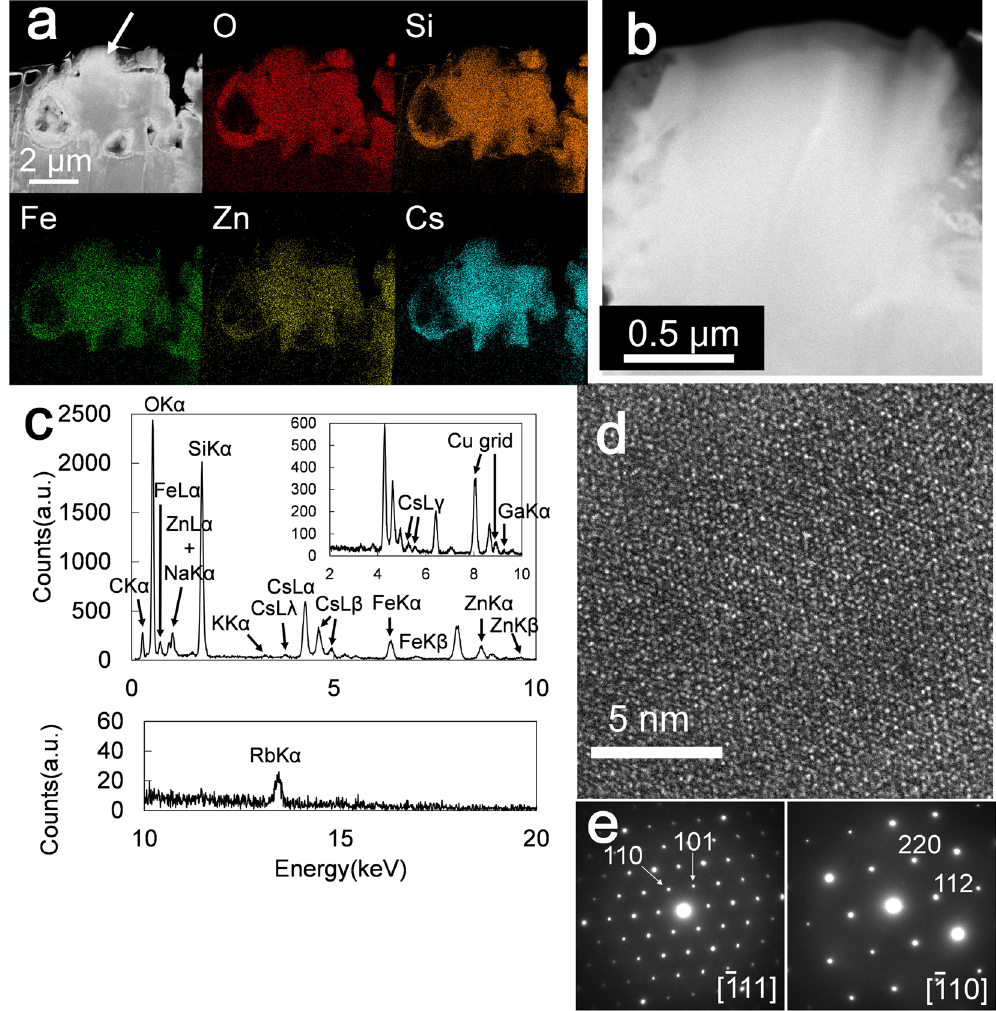
Figure 4. ( a ) HAADF-STEM image of the FIB-TEM specimen OTZ3-2 associated with the elemental maps. ( b ) A magnified HAADF-STEM image of the high Cs phase indicated by the arrow in ( a ). ( c ) A representative EDX spectrum of the high Cs phase indicated by the arrow in ( a ). ( d ) HRTEM image of the high Cs phase indicated by the arrow in ( a ). ( e ) The SAED pattern of the high Cs phase from two different major zone